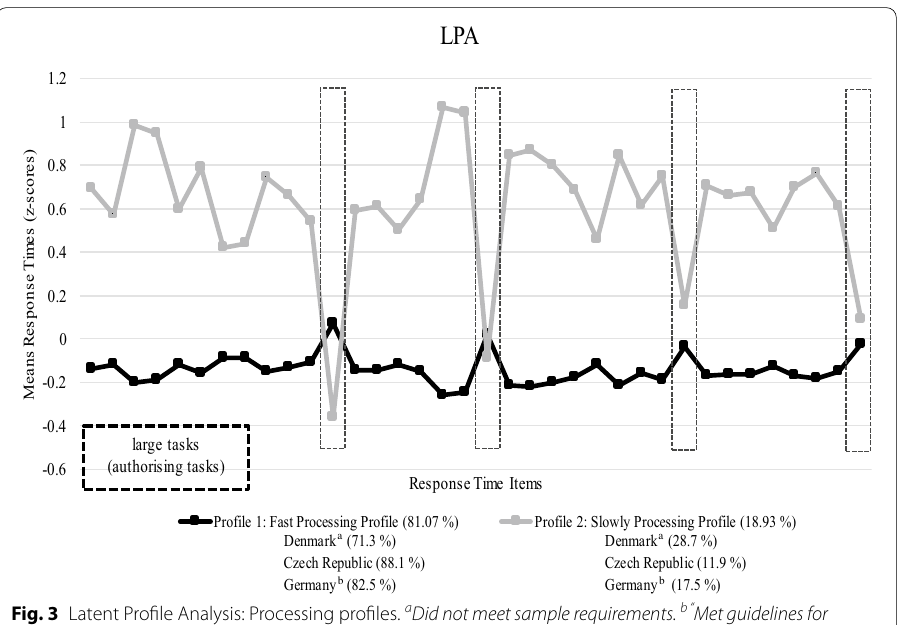
Fig. 3 Latent Profile Analysis: Processing profiles. a Did not meet sample requirements. b “ Met guidelines for sampling participation rates only after replacement schools were included” ( Fraillon et al. 2014 , S.